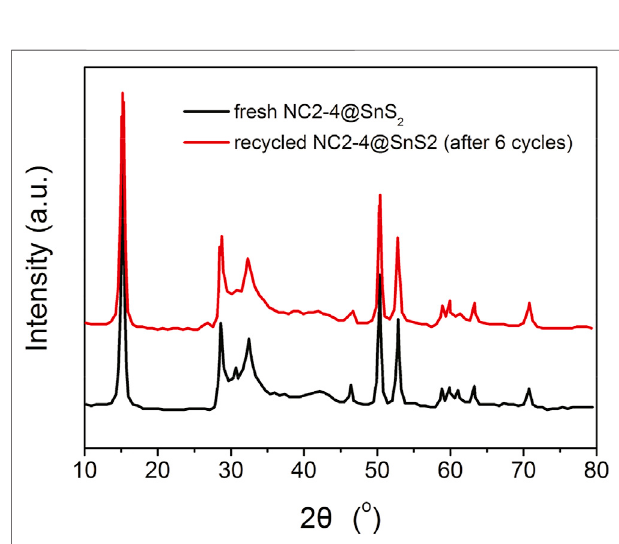
The detailed fi tting parameters are listed in Table 1 . Good linear fi tting is observed. The k-value of NC2-4@SnS 2 is the highest one among NC@SnS 2 samples.